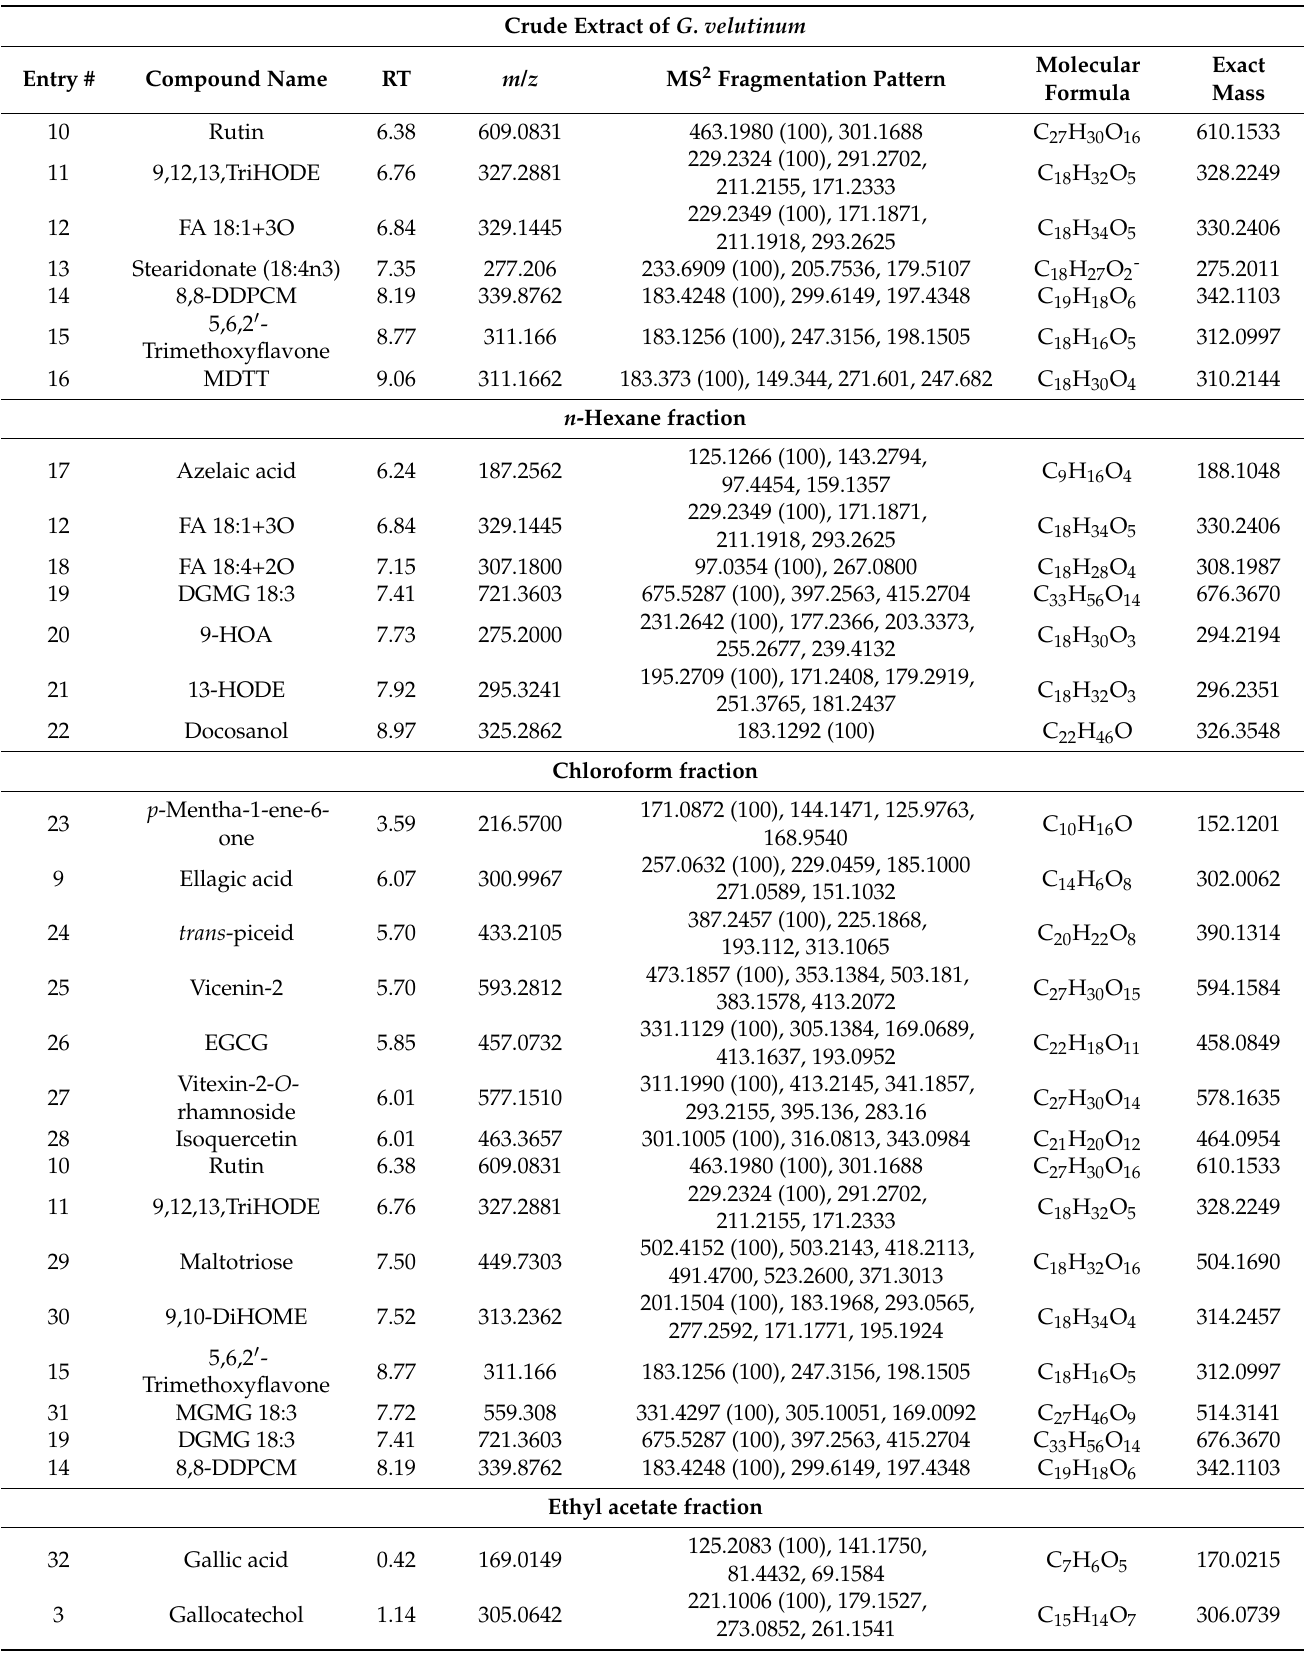
Table 3. Cont. Crude Extract of G.